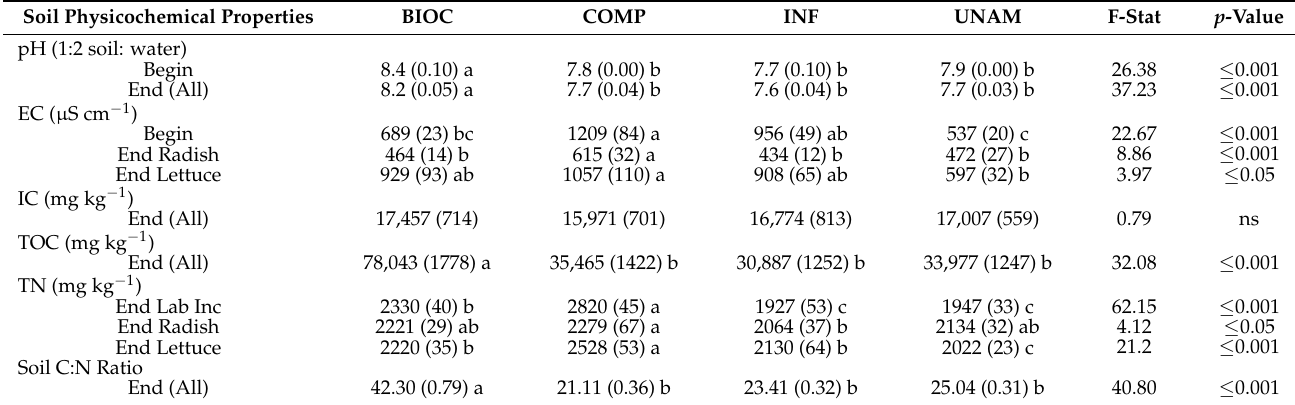
Table 3. Soil physicochemical properties: pH, electrical conductivity (EC), inorganic carbon (IC), total organic C (TOC), total nitrogen (TN), and C to N ratio (C:N) in soils amended with biochar (BIOC), compost (COMP), inorganic fertilizer (INF), and from unamended control (UNAM). Values represent mean averages with standard errors in parentheses. Measurements at the beginning of the experiment before plant seeding are denoted as “Begin.” Measurements at the end of the experiment are marked “End.” The data are provided for individual plant species (End Radish and End Lettuce) and lab incubated soil (End Lab Inc.) if statistical differences existed among these groups for each soil treatment or, alternately, presented across all samples if there were no differences between groups (“All”). Lowercase letters indicate statistically significant differences by treatment. If there were no differences between treatments, “ns” is indicated. Statistical tests were performed using a two-way Analysis of Variance (ANOVA) or Kruskal-Wallis if data could not be normalized. Tukey HSD or Dunn’s test were used to determine treatment significance of p ≤ 0.05 at minimum.